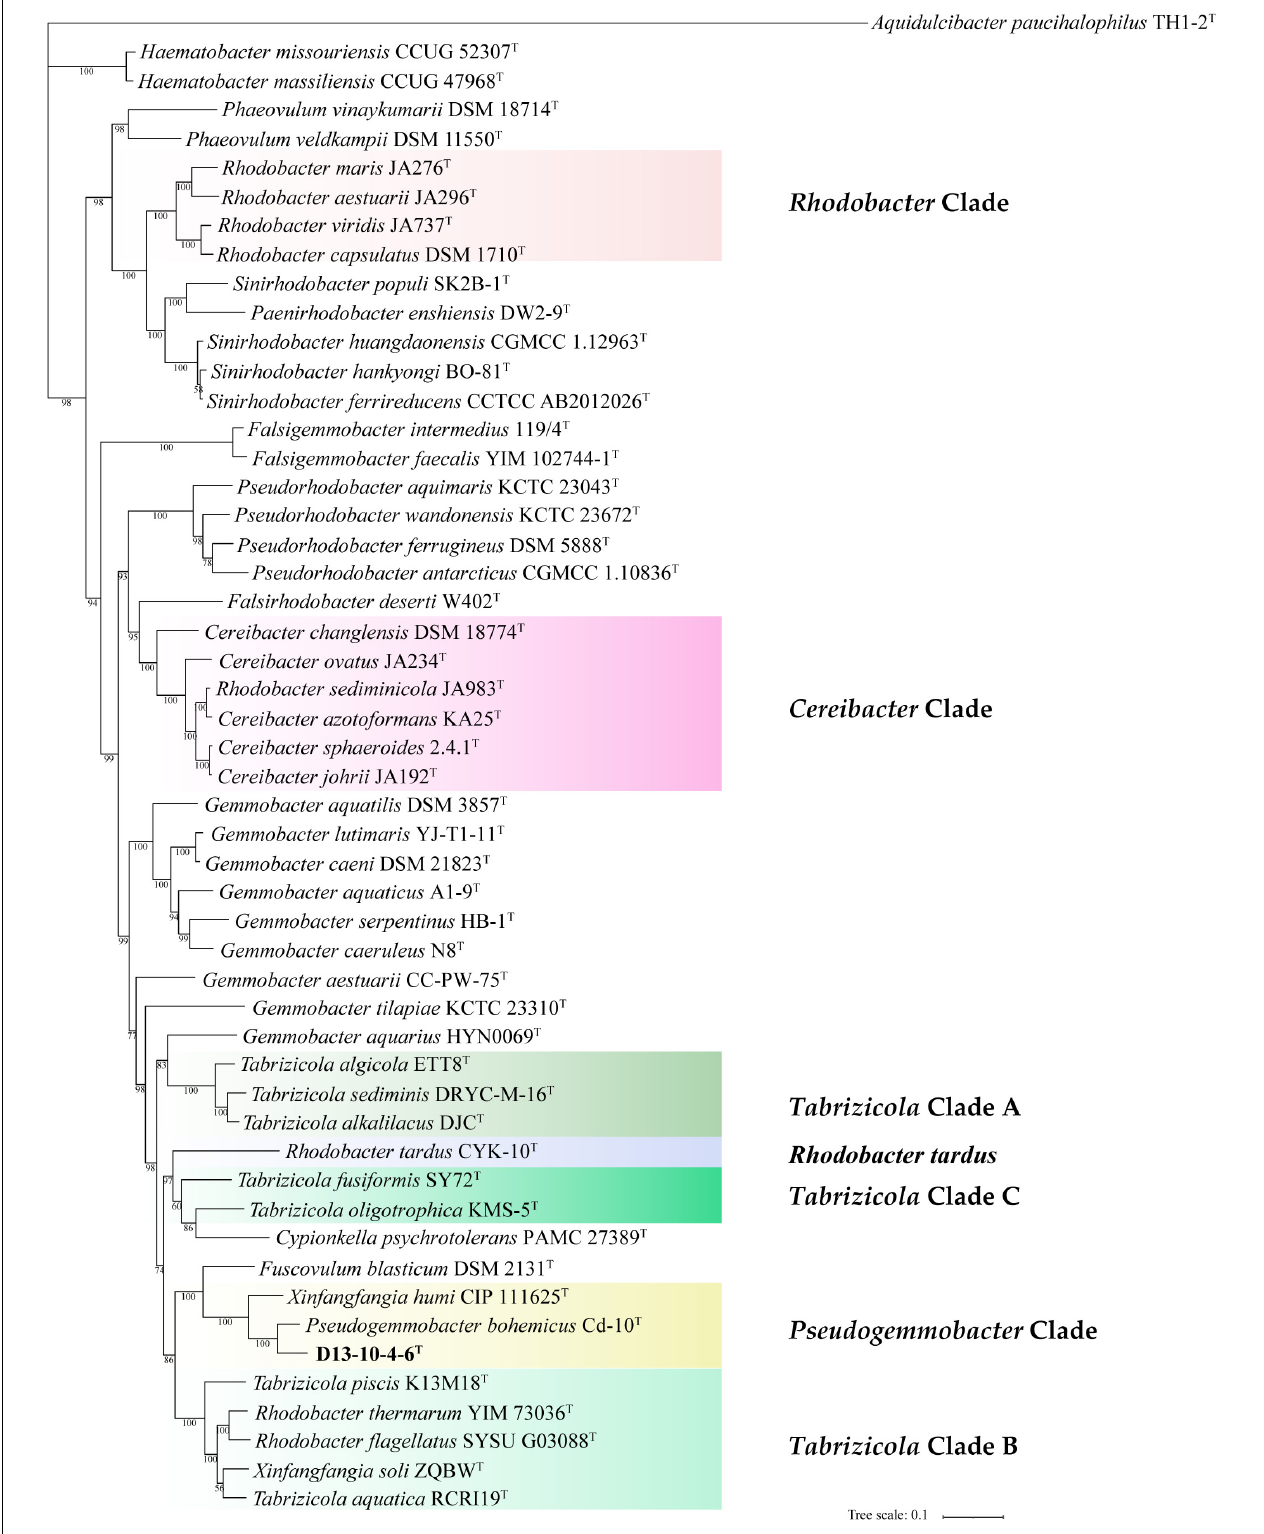
FIGURE 3 | Phylogenetic tree among strain D13-10-4-6T and reference strains based on a concatenated alignment of 120 ubiquitous single-copy proteins. Aquidulcibacter paucihalophilus TH1-2T was used as an outgroup. The scale bar corresponds to 0.1 substitutions per amino acid position.